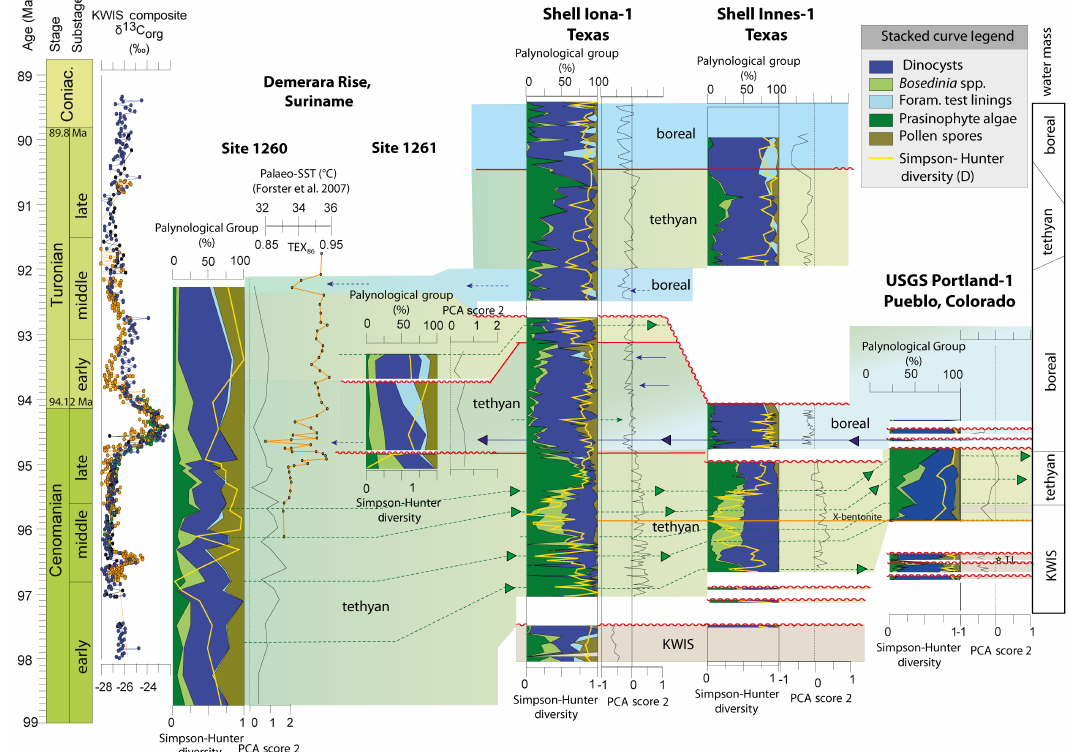
Figure 13. Cenomanian–Coniacian chronostratigraphic correlation of interpreted water masses along a south–north transect from the equato- rial western Atlantic to the central Cretaceous Western Interior Seaway (KWIS). The KWIS composite δ 13 C org after Joo and Sageman (2014) and including data from Du Vivier et al. (2014), Eldrett et al. (2015a) for USGS Portland-1 (orange), plus data from Iona-1 (blue), Innes-1 (black) and well “X” (green) cores calibrated using the age model of Eldrett et al. (2015a). Stacked curves showing principal palynologi- cal components (legend on figure). Palaeo-SST and TEX 86 record from ODP Site 1260 from Forster et al. (2007). Colour shading: green, Tethyan-sourced water from the equatorial Atlantic; blue, northerly boreal water mass; brown, locally sourced KWIS water mass. Green dashed arrows indicate Tethyan incursions; blue arrows indicate boreal influence. Principal component analysis (PCA) score axis 2: positive indicative of eutrophic/anoxic waters; negative indicative of oxygenated oligotrophic waters (see Fig.